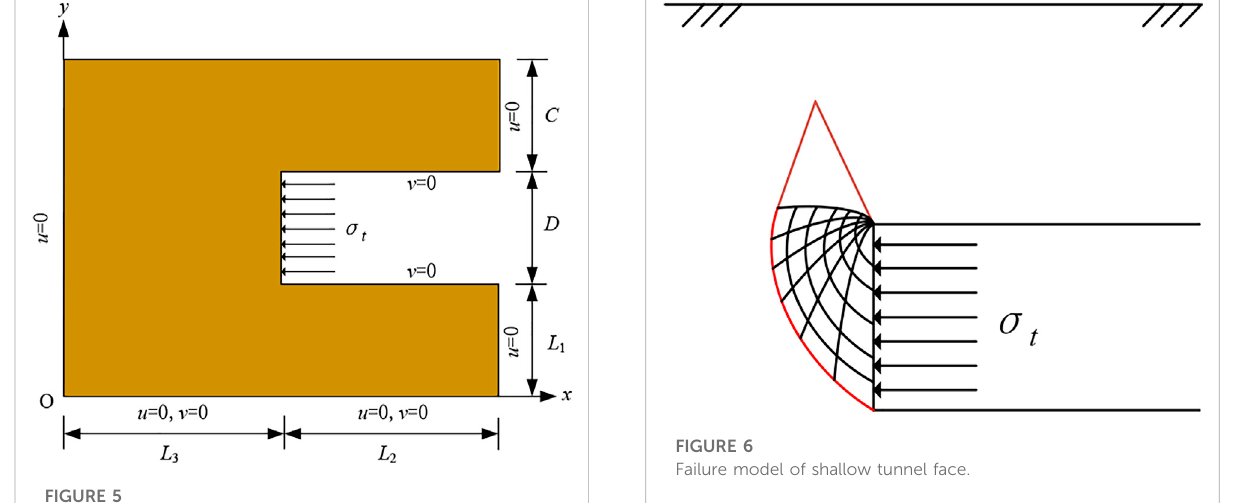
FIGURE 5 Stability analysis model of tunnel face.